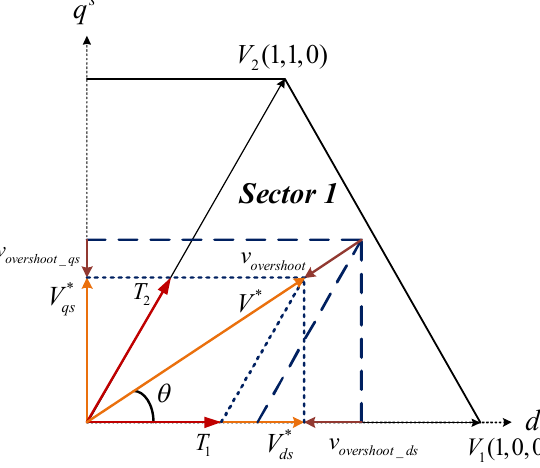
Figure 7. The altered reference voltage in Sector 1 of space vector pulse width modulation (SVPWM). Figure 7.